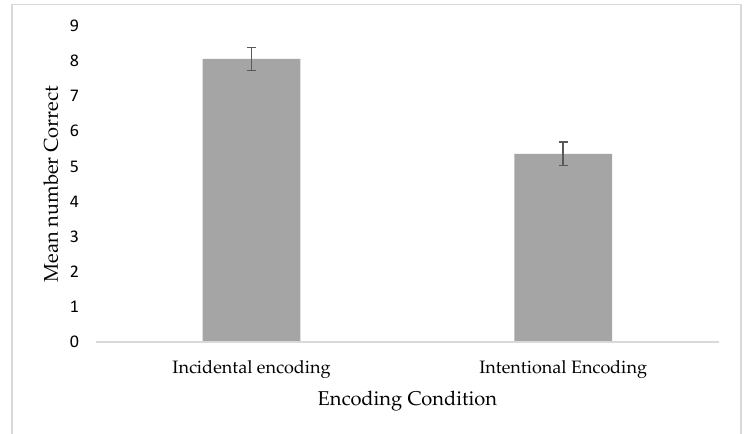
Figure 1. Mean number of correctly detected location-exchanged objects under divided attention incidental and intentional encoding conditions for the total scores. Error bars represent standard errors of the mean (SEM). Brain Sci. 2020 , 10 , x FOR PEER REVIEW